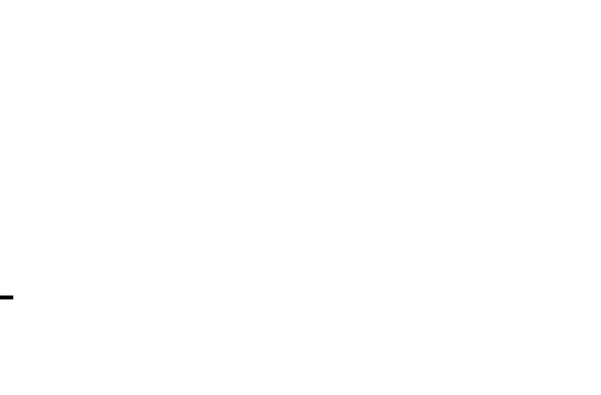
Figure 8. Empirical validation of the glutathione S-transferase activity in uninfected and infected with ‘ Ca . P. solani’ grapevines cv. Zweigelt in the late growing season. FW, fresh weight; the data refer to means ± standard deviation. * p < 0.05 (Mann-Whitney test).